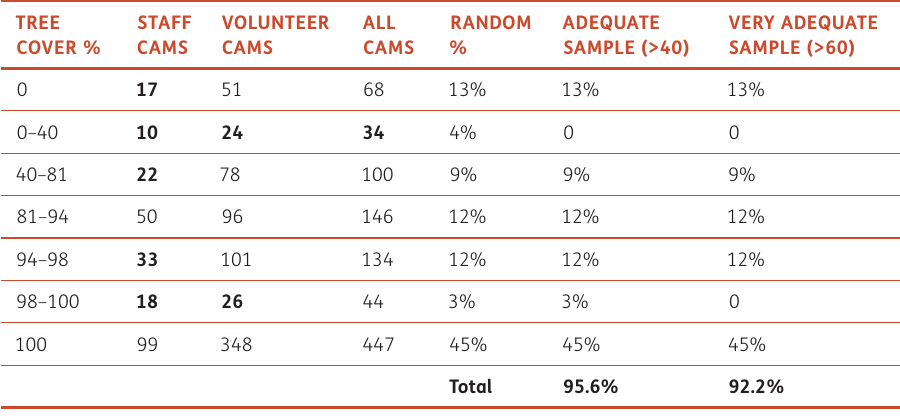
Table 3 Example of results for the representation of the camera trap sampling for one ecoregion (mountains) for one habitat type (tree cover). Columns show number of cameras set in each habitat type by staff, volunteers, and total. Habitat types with <40 camera samples ( bold ) were judged to be insufficiently sampled. In this example, additional sampling by staff ensured adequate sampling for the 98–100% category but not for the 0–40% category. The proportional availabilities of a habitat categories for that ecoregion are given by the % of random points that fell into that category, which are then summed if they are sampled adequately (>40 pts) or very adequately (>60) to quantify the total % of a given habitat type adequately sampled in a given ecoregion. Additional habitats/ecoregion results are in Appendix